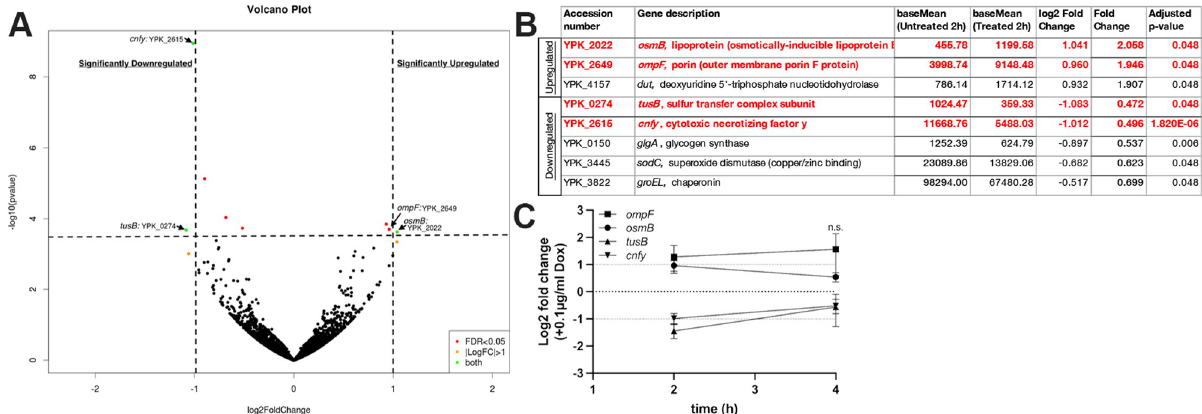
Fig 1. ompF , osmB , CNFy , and tusB are differentially regulated in response to doxycycline. Cultures of WT Y . pseudotuberculosis were incubated in the presence or absence of 0.1 μ g/ml Dox and bacterial transcript levels were compared by RNA-seq. Significant changes in transcript levels were detected at 2h post-treatment by DESeq2 analysis. (A) Volcano plot of aligned genes, each dot represents one gene. Horizontal dotted line: adjusted p value of 0.05, genes above this line are considered significantly altered. X-axis: log2 fold change in transcript levels. Vertical lines mark 2-fold changes, genes outside these lines are differentially regulated more than 2-fold. Hits of interest are highlighted. (B) Table of significant hits, 2h post-treatment. Hits of interest (differentially regulated ~2-fold) are highlighted in red. Base mean values represent 4 biological replicates. Log2 fold change and fold change are shown with adjusted p-value (adjusted based on gene length). (C) qRT-PCR validation of RNA-seq results. Cultures were prepared as described above, and bacterial transcripts were detected by qRT-PCR. Log2 fold change values were calculated relative to untreated cells, horizontal dotted lines depict average values for untreated cells (0log2), and 2-fold changes. Data represents four biological replicates. Statistics: (C) Two-way ANOVA with Tukey’s multiple comparison test, comparisons made relative to untreated cells. n.s.: not significant.